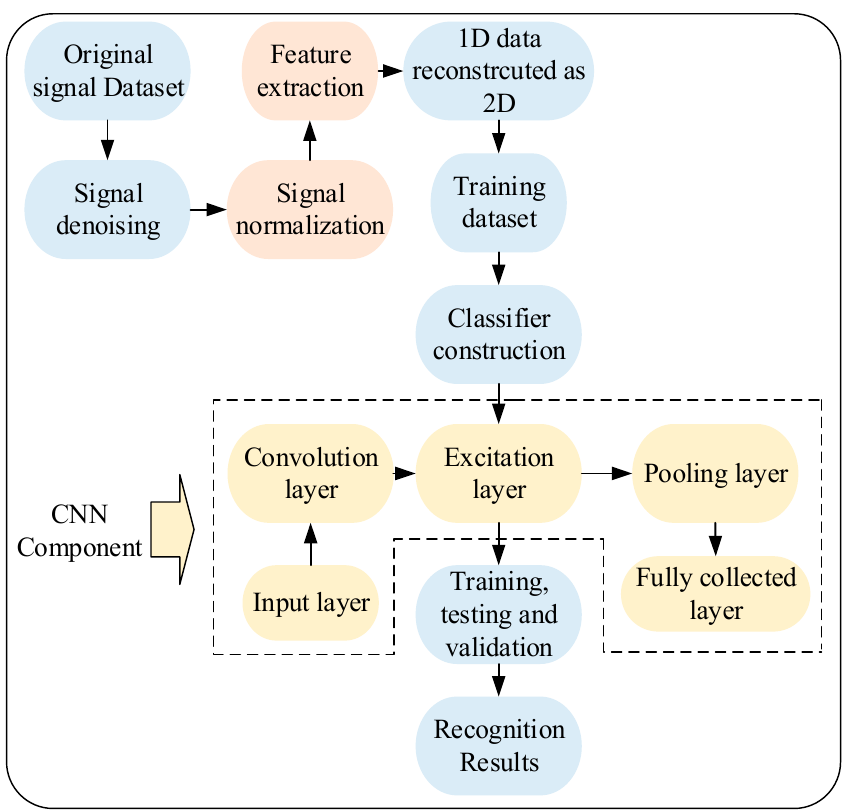
Figure 11. Schematic diagram of the wire rope defect recognition by signal analysis and CNNs.